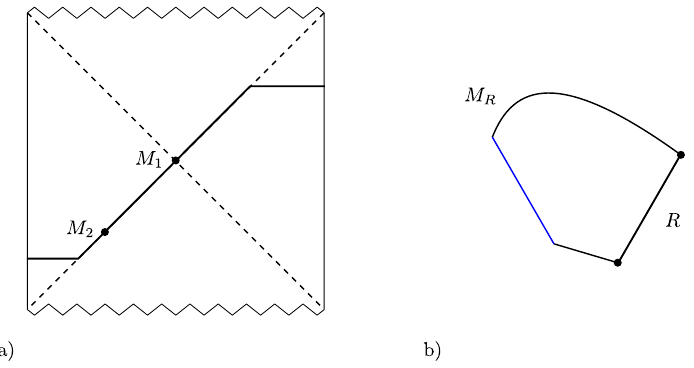
Figure 6 . The stability requirement rules out certain maximin surfaces. In a) we take our region R to be one entire boundary in the eternal Schwarzschild-AdS geometry. All surfaces on the horizon have the same area, but only M 1 at the bifurcate horizon is stable. In b) We have a maximin surface with a null segment (blue), which is not